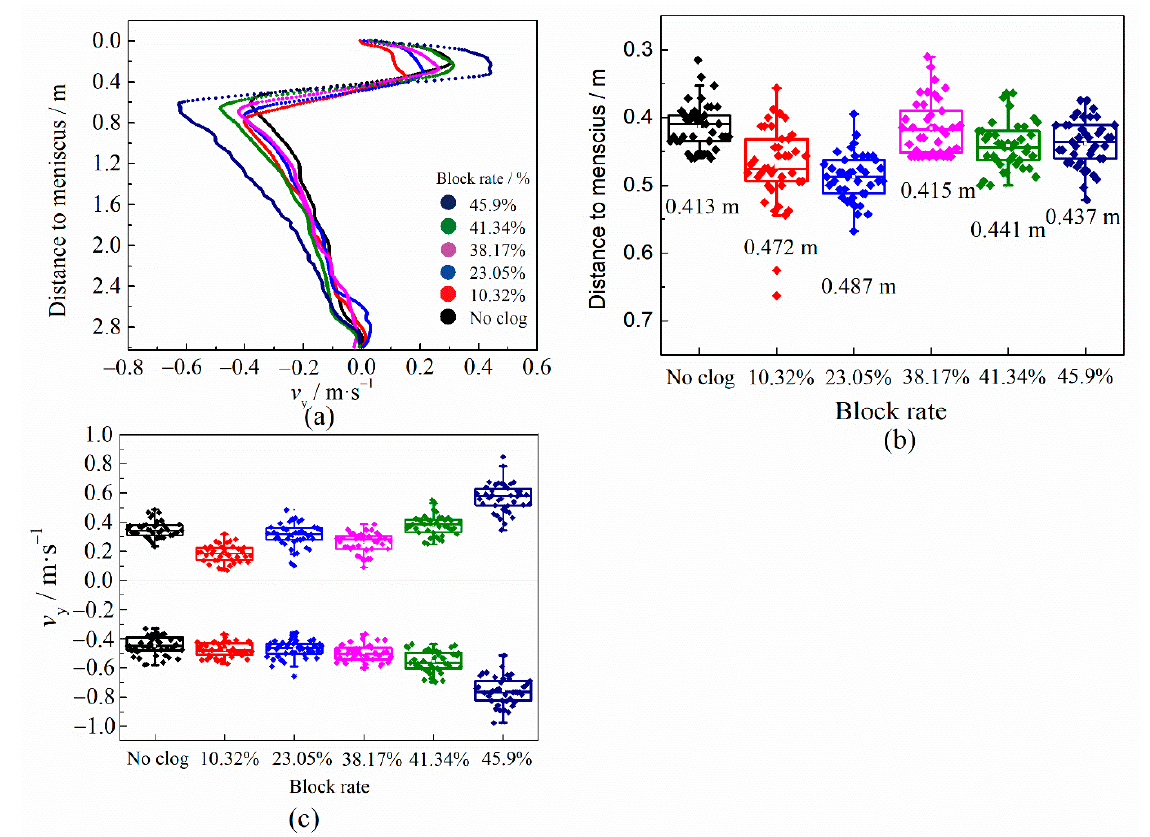
Figure 7. The quantitative indicator of the influence of block rate on flow. ( a ) Time-averaged distribution of v y near the center of the narrow side of the mold, ( b ) the distribution of steam impact-point on the narrow side, ( c ) the distribution of the maximum and the minimum of v y .